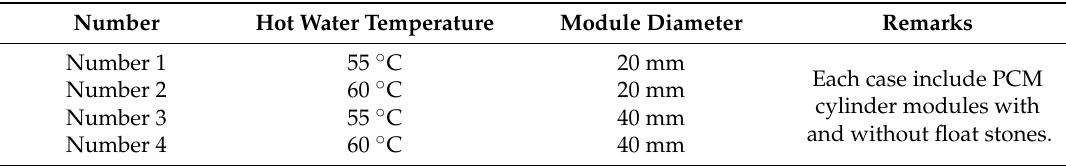
Table 2. Arrangements of constant temperature water bath tests.